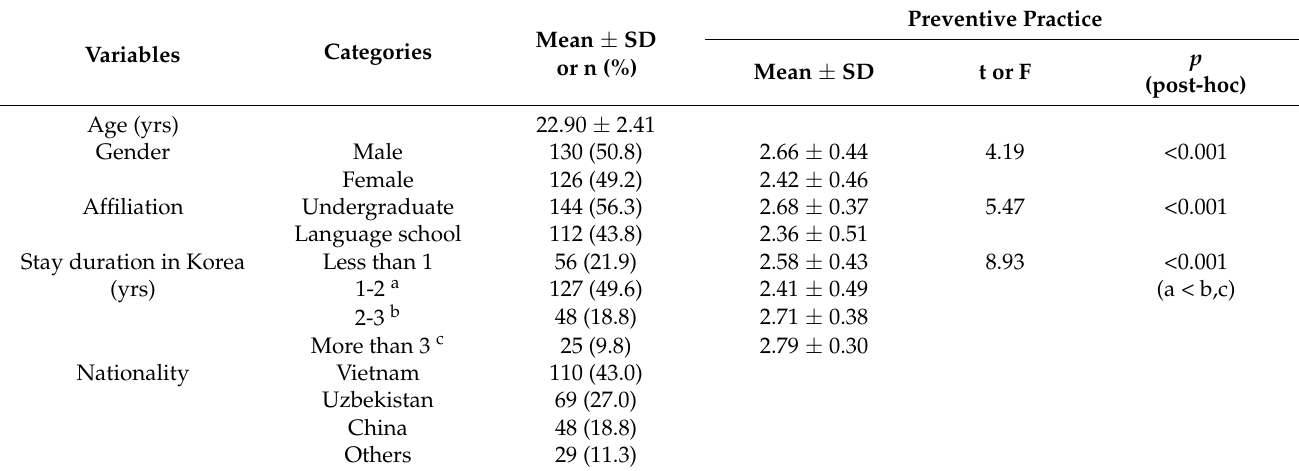
Table 1. Preventive practice according to general characteristics ( N =